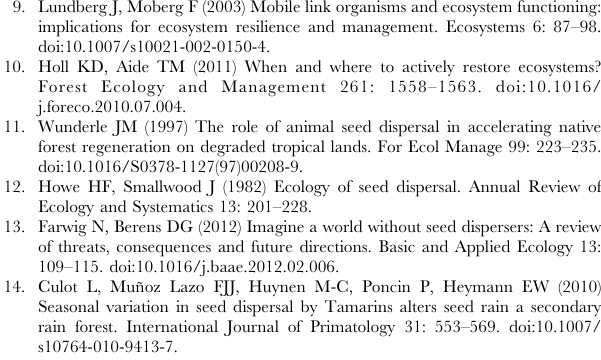
Figure S1 Seed rain in degraded forest with respect to distance from intact karst forest boundary. Table S1 Summary of tree species found in forest surveys or seed traps, with biogeographic